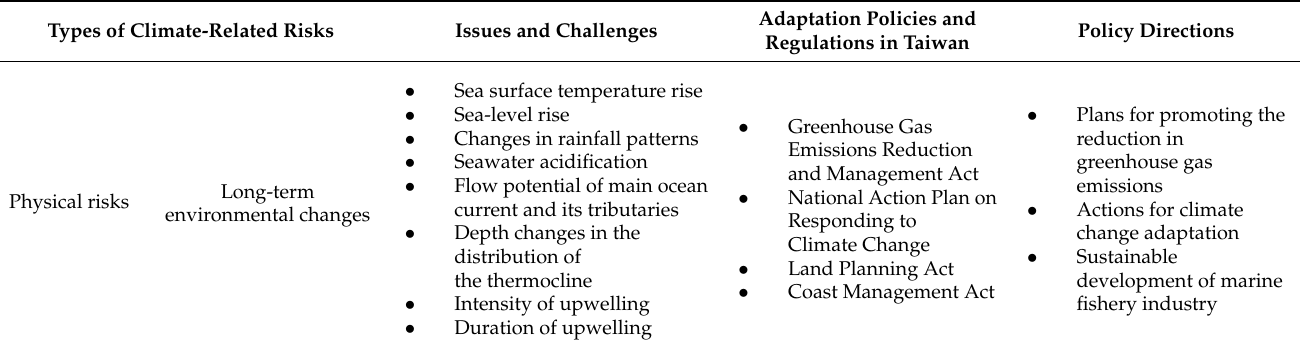
Table 3. Adaptation policies and regulations, issues, and challenges for policy directions and direc- tions of the marine fishery industry in response to types of climate-related